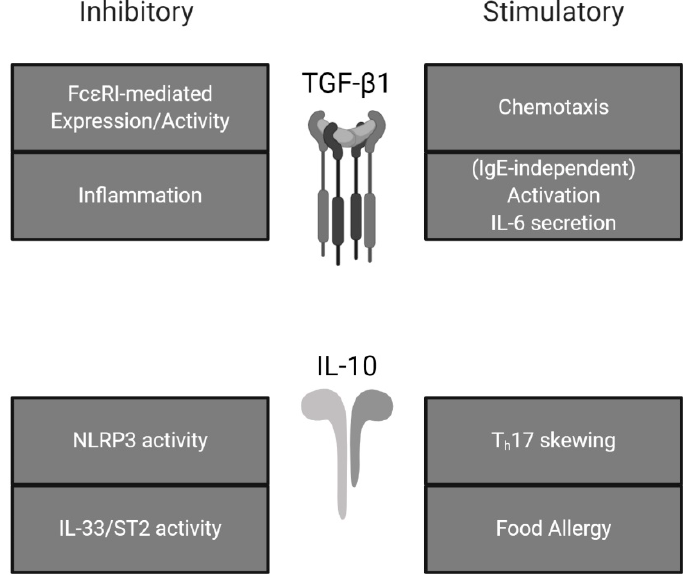
Figure 2. Effects of TGF- β 1 and IL-10 on mast cell activity. TGF- β 1 and IL-10 exhibit both stimulatory and inhibitory effects on mast cells. Summarized from the present review.